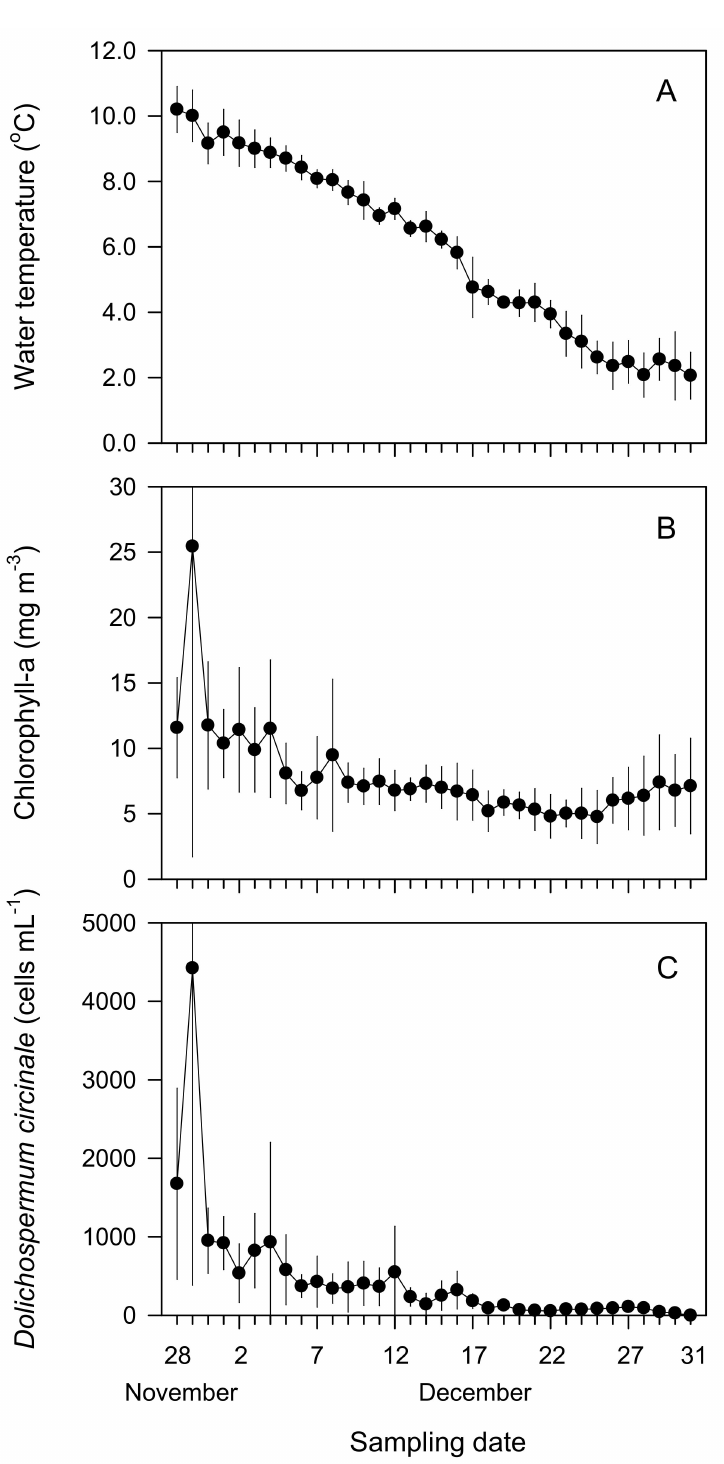
Figure 6. Daily variations of the ( A ) water temperatures, ( B ) chlorophyll- a concentrations, and ( C ) cell numbers of Dolichospermum circinale (formerly Anabaena circinalis ) observed in four stations of the Euiam and Cheongpyeong Reservoirs of the North Han River and Paldang Reservoir of the Han River from 28 November to 31 December